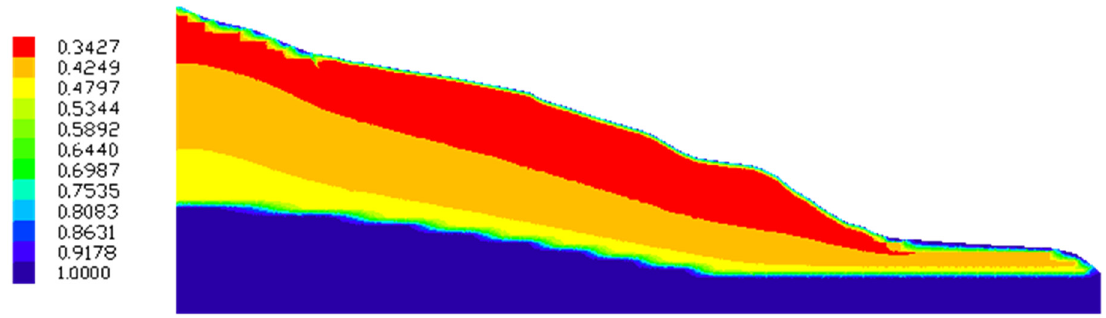
Figure 11. Cloud picture of saturation distribution at the rainfall time of 2 h.